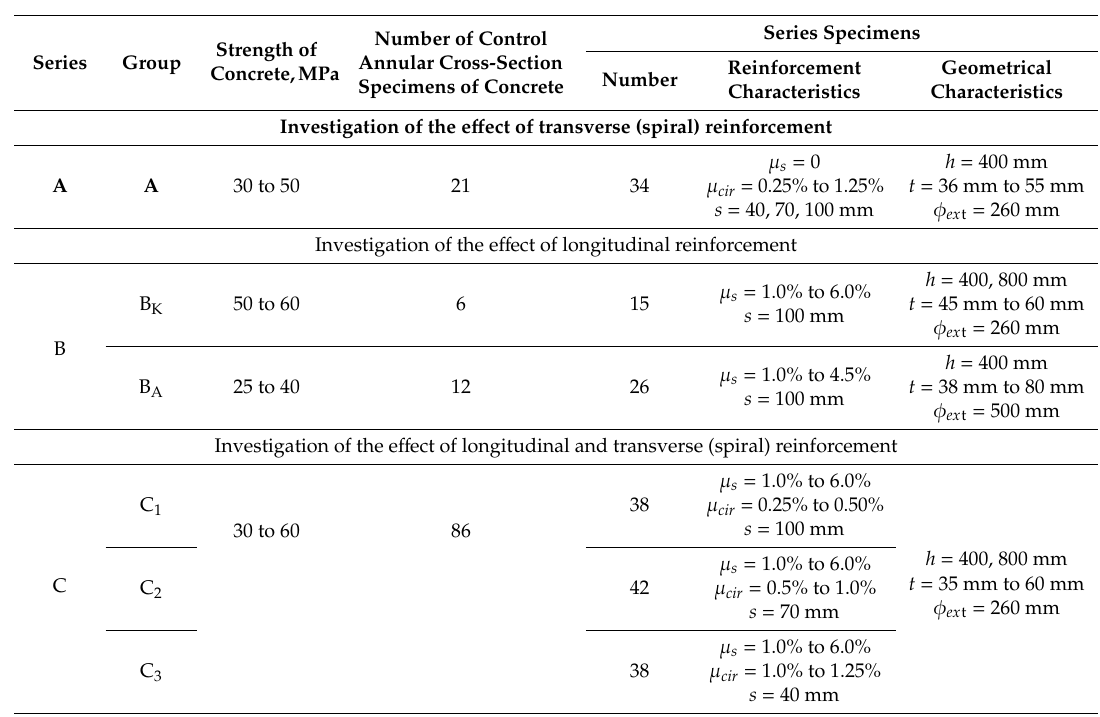
Table 2. Research plan for the reinforcement e ff ect of concrete strength and deformability of centrifuged annular cross-section elements. Main characteristics of test